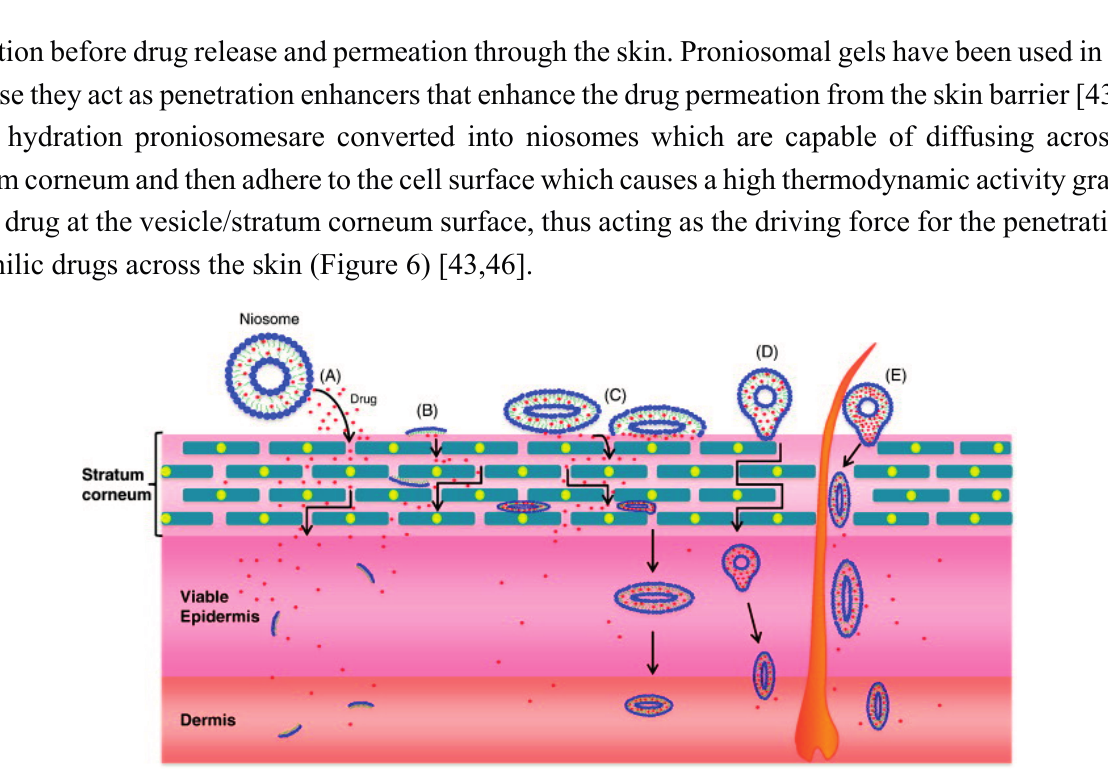
Figure 6. Possible mechanisms of action of surfactant vesicles for dermal and transdermal applications: ( A ) drug molecules are released by niosomes; ( B ) niosome constituents act as penetration enhancer; ( C ) niosome adsorption and/or fusion with stratum corneum; ( D ) intact niosome penetration through the intact skin; ( E ) niosome penetration through hair follicles and/or pilosebaceous units. (Reprinted from [46] with permission. Copyright 2014